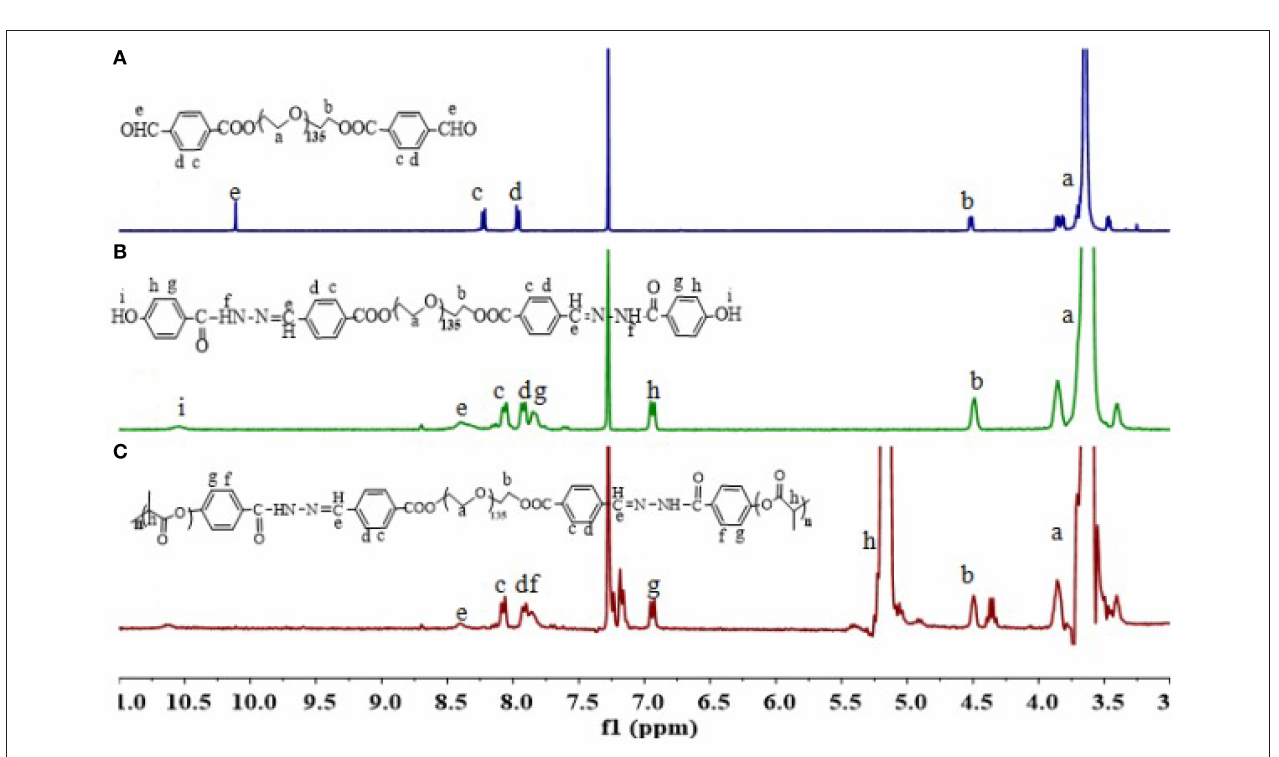
FIGURE 3 | 1 H-NMR spectra of polymers CHO-PEG-CHO (A) , PEG-DiHyd (B) , and PEG-DiHyd-PLA (C) .